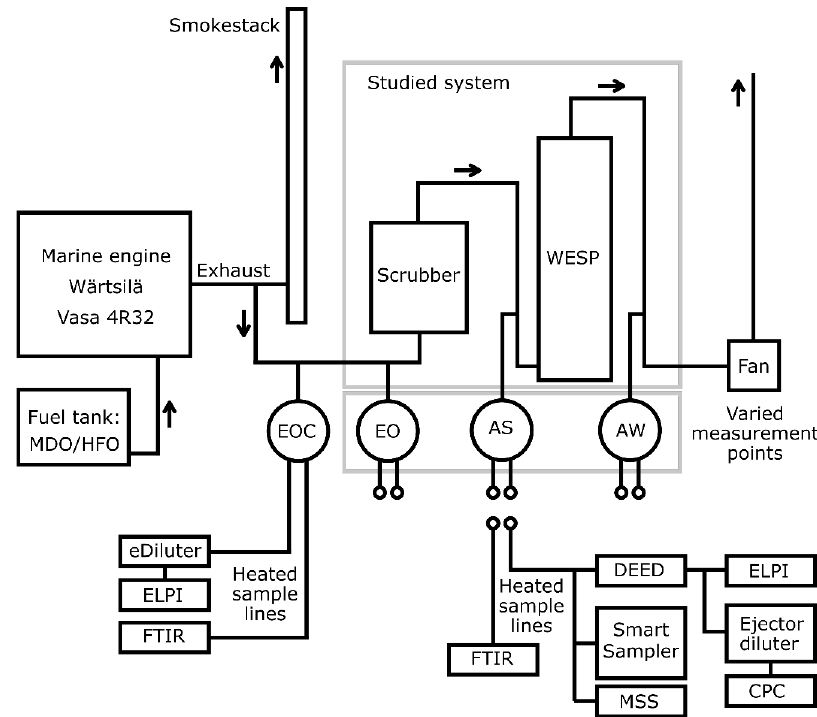
Figure 1. Schematic of the measurement setup. Instrument sampling point was switched between EO, AS, and AW positions during the study. The same sampling probe was used in these sampling points. Instrument setup connected to EOC with a separate probe remained constant during the study. Arrows illustrate direction of the flow in the system.